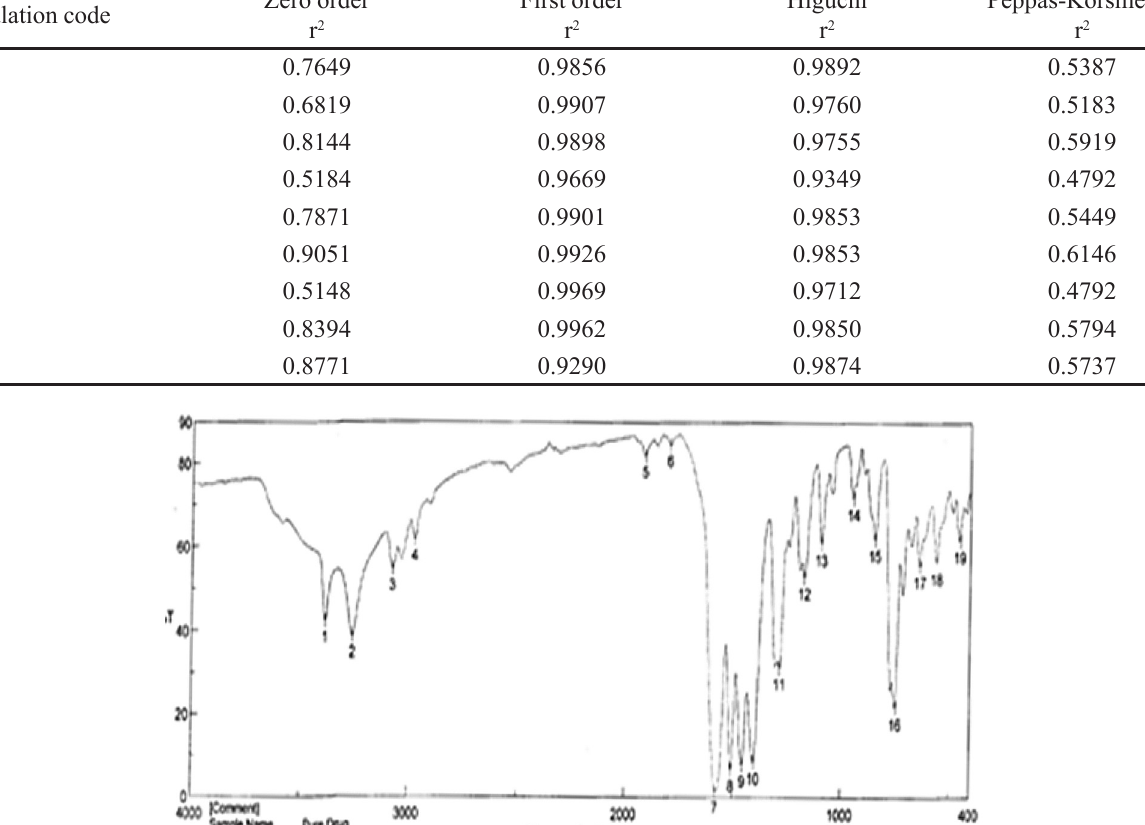
Formulation code